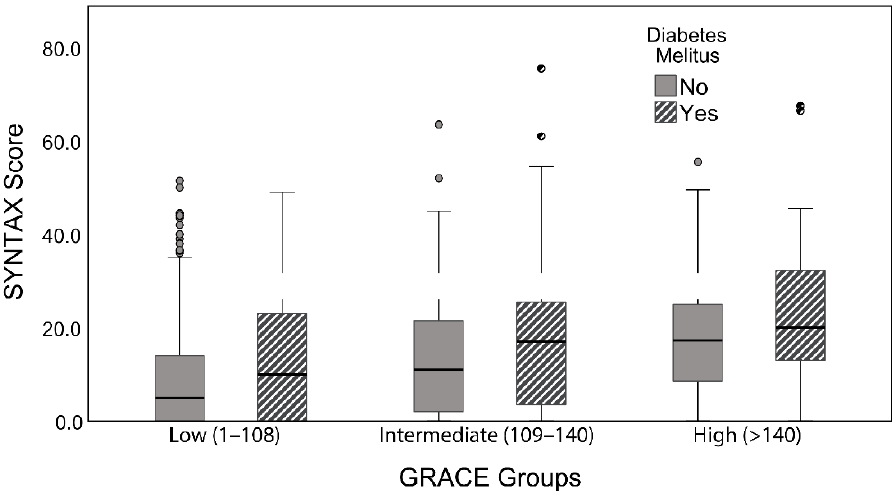
Figure 3. The median SYNTAX score of diabetic patients was higher than that of non-diabetic patients among the three different classes (low, intermediate, and high) of the calculated GRACE score.